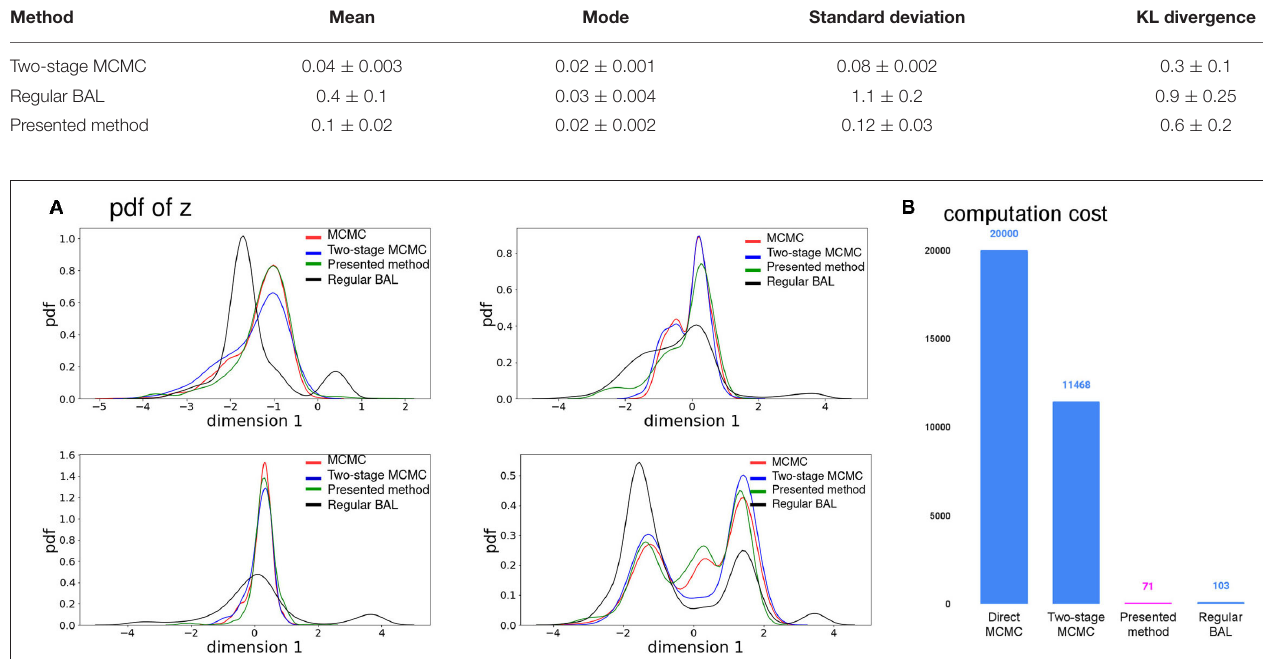
FIGURE 3 | (A) Comparison of estimated posterior pdf from different methods. (B) Comparison of computation cost from different